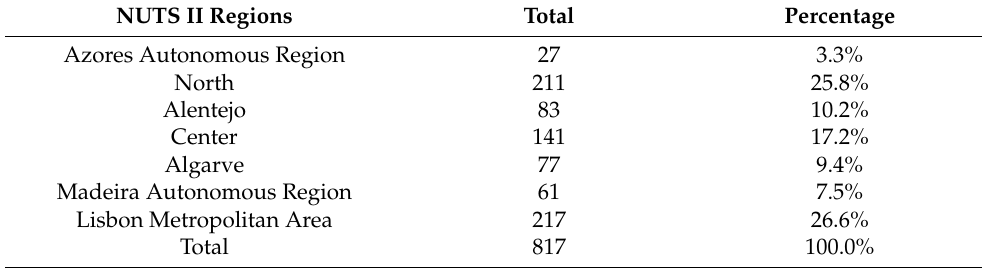
Table 5. Hotel companies through NUT II.